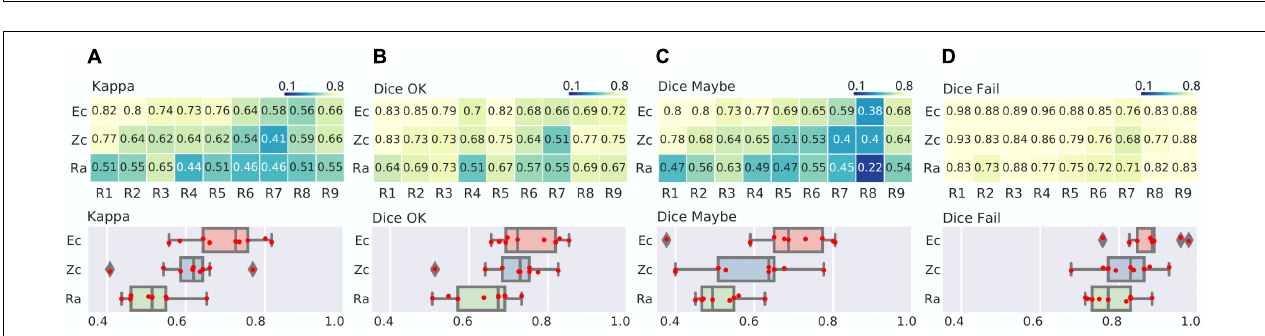
FIGURE 2 | Between-expert agreement. (A) Matrix of Kappa agreement between raters (top). Note that R1 to R9 are identification codes for the different expert raters. The distribution of agreement is also presented (bottom). For example, the boxplot for R1 shows the agreement between R1 and R2-R9. (B–D) Matrix and distribution for the Dice agreement between raters in the OK (B) , Maybe (C) , and Fail (D) categories.